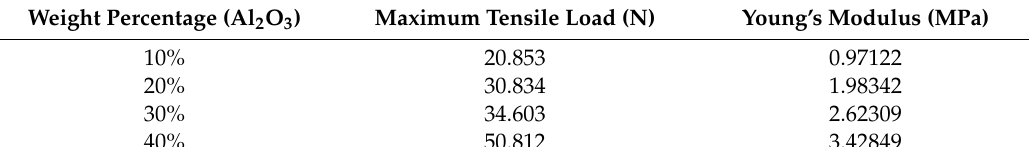
Figure 7. Curve Graph of Tensile Test. Table 3. Mixed test results of PDMS with mixtures of 10~40% alumina powders.